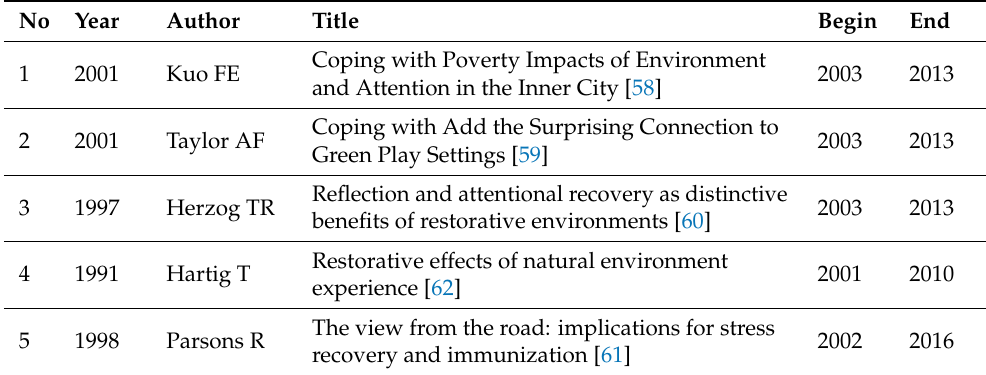
Table 2. Top 5 references with the strongest burst citation for the first step of the review, restoration processing.